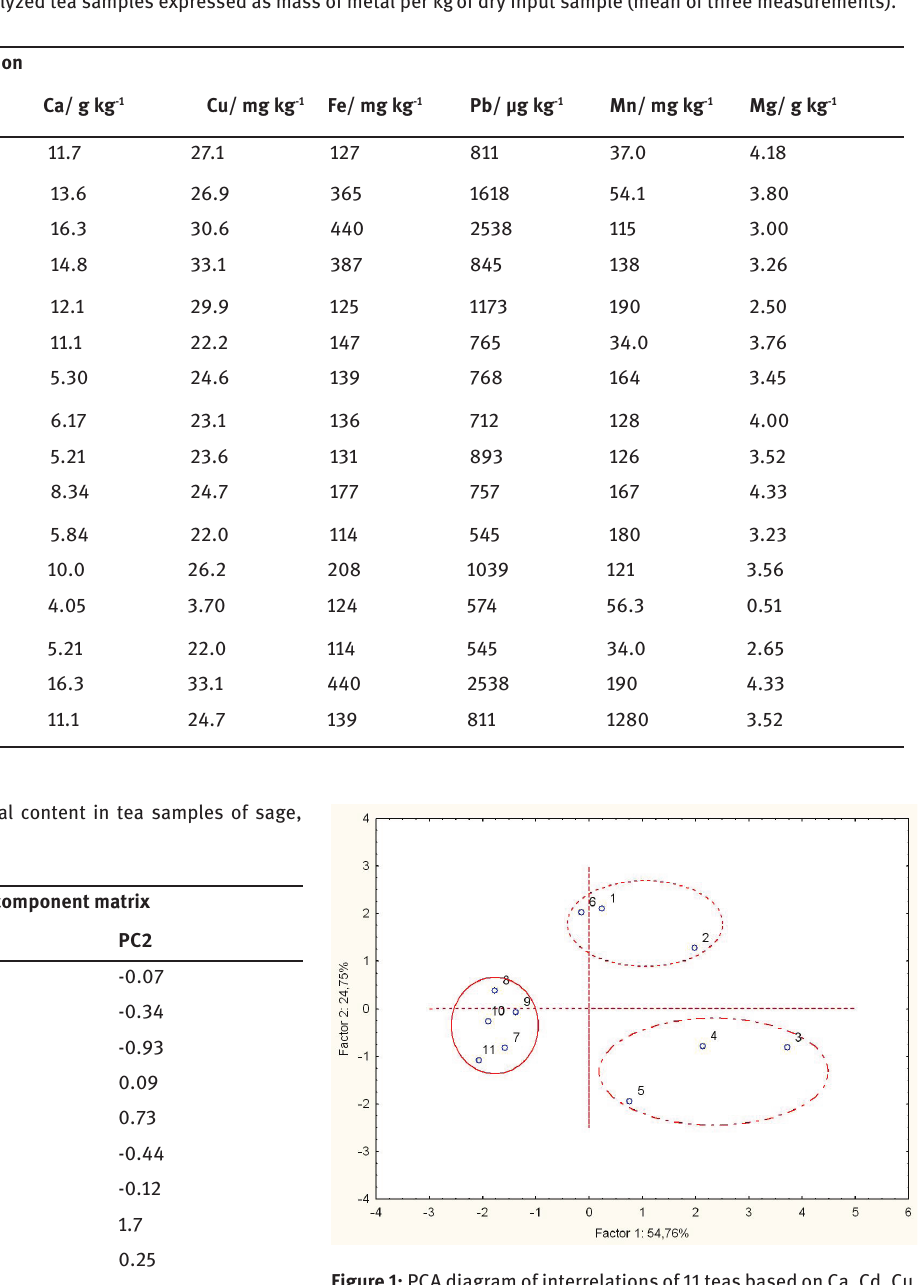
Figure 1: PCA diagram of interrelations of 11 teas based on Ca, Cd, Cu, Fe, Mg, Mn and Pb